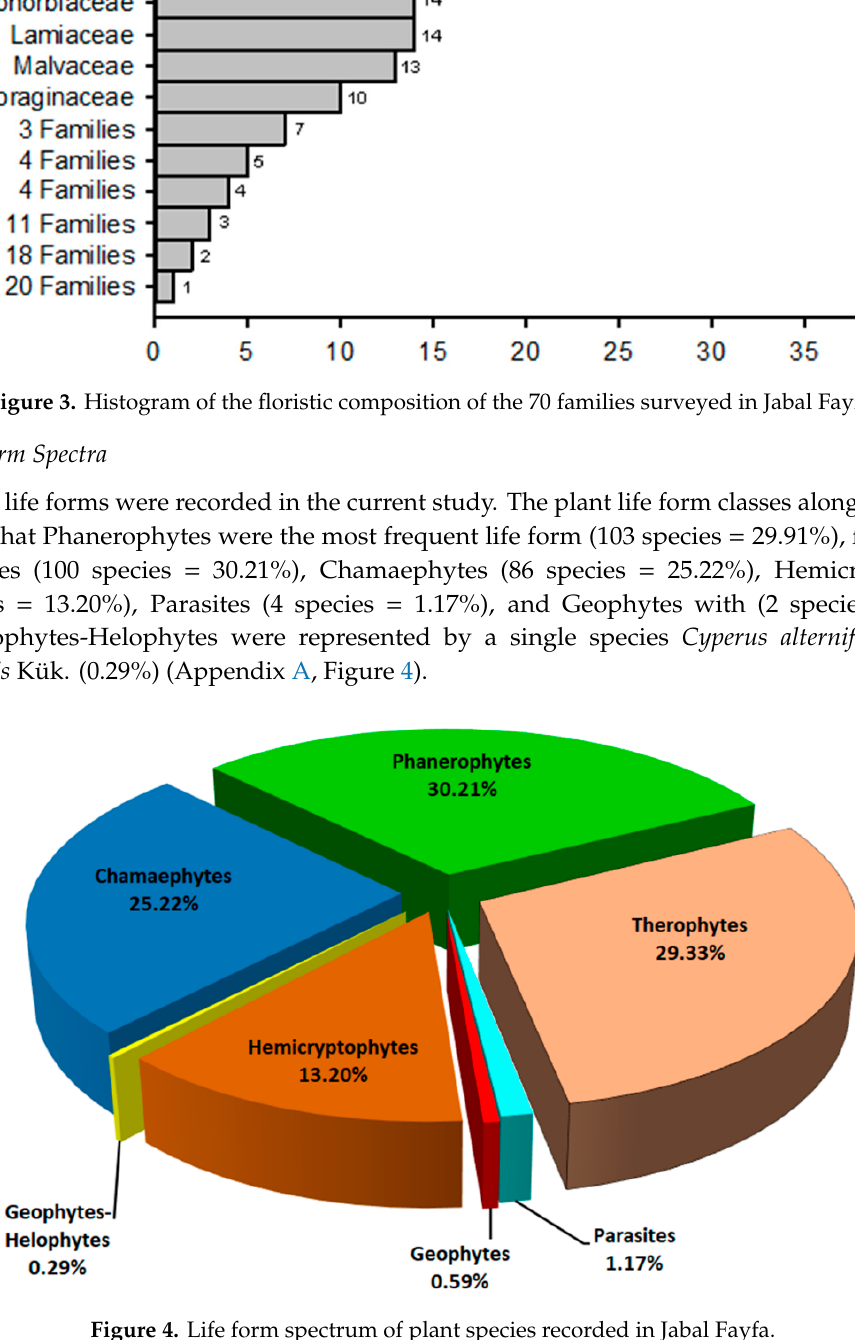
Figure 4. Life form spectrum of plant species recorded in Jabal Fayfa.